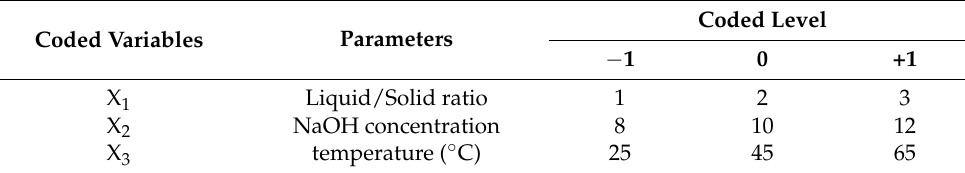
Table 3. The range and levels of experimental variables (parameters).